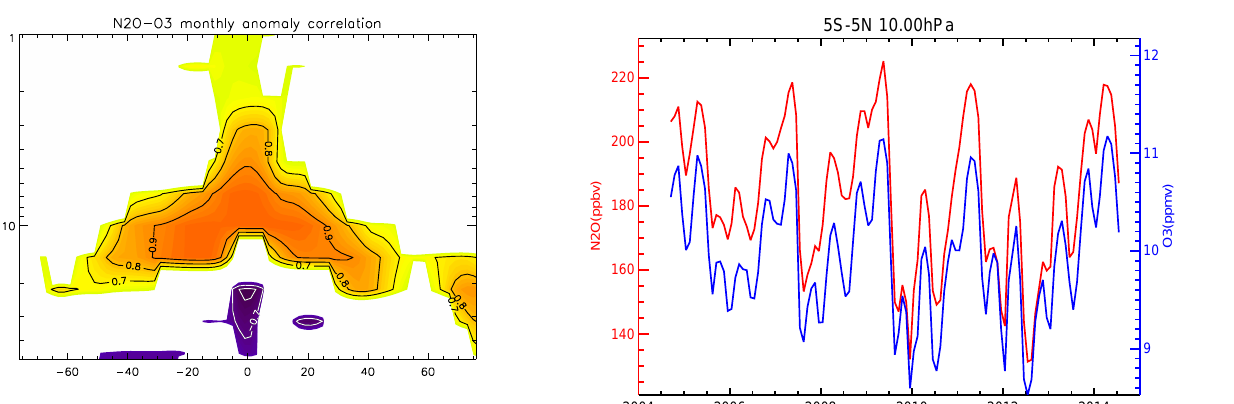
Figure 4. Correlation coefficients between N 2 O and O 3 calculated from monthly median anomalies from MLS data as a function of latitude and pressure. Results are shown for regions where the cor- relation (or anti-correlation) is >0.6.